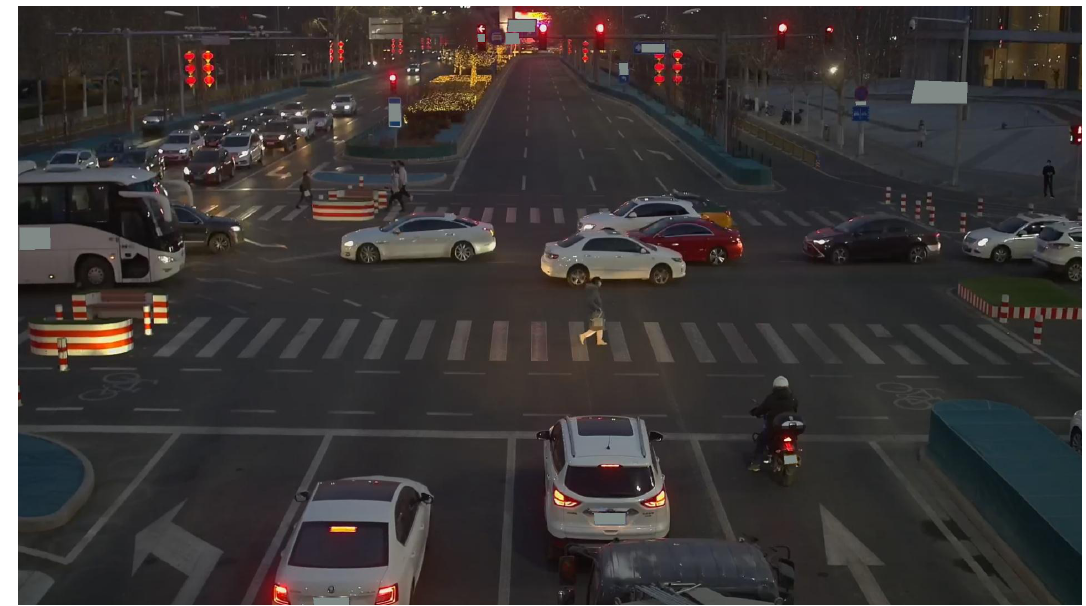
Figure 9. A dataset sample